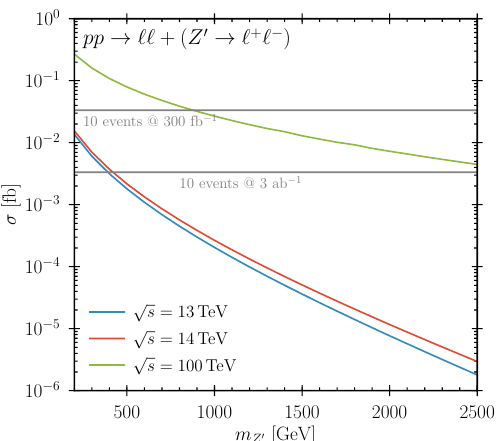
Figure 7 . Z 0 production cross section in the absence of kinetic mixing for LHC-13 (blue), LHC-14 (red), and a 100 TeV collider